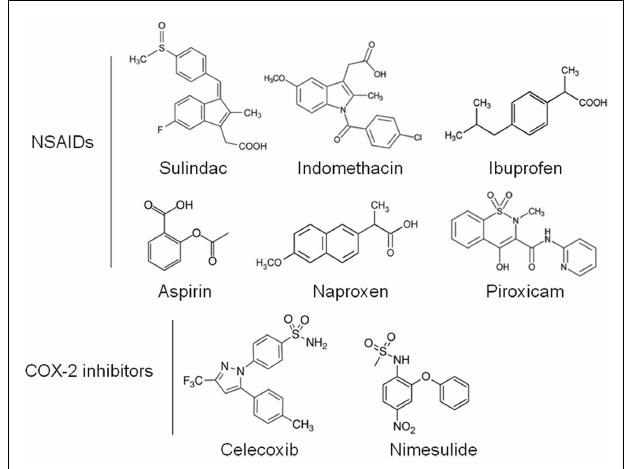
FIGURE 1 | Chemical structures of common NSAIDs and selective COX-2 inhibitors .